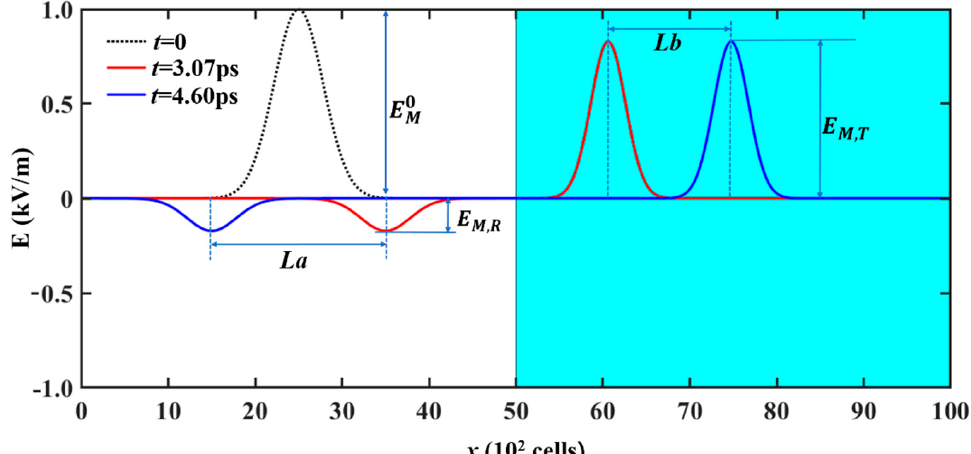
Figure 1. Distribution of an electric pulse crossing a dielectric interface. The shaded zone represents the dielectric medium, with a dielectric constant of ε r = 2.0, and the nonshaded zone corresponds to the medium with ε r = 1.0.